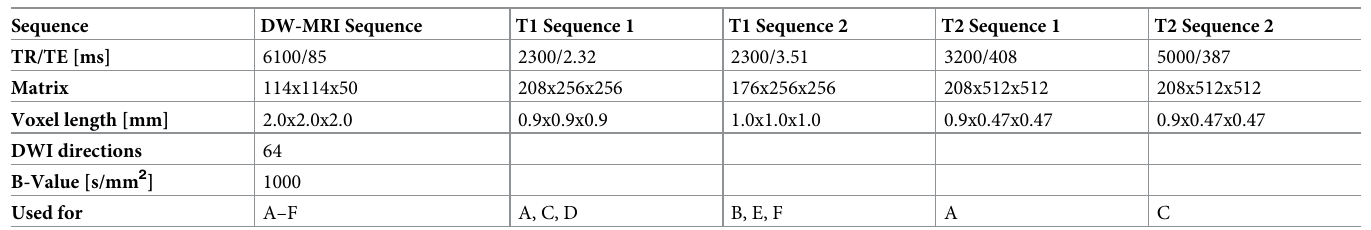
Table 2. Overview of the clinical acquisition